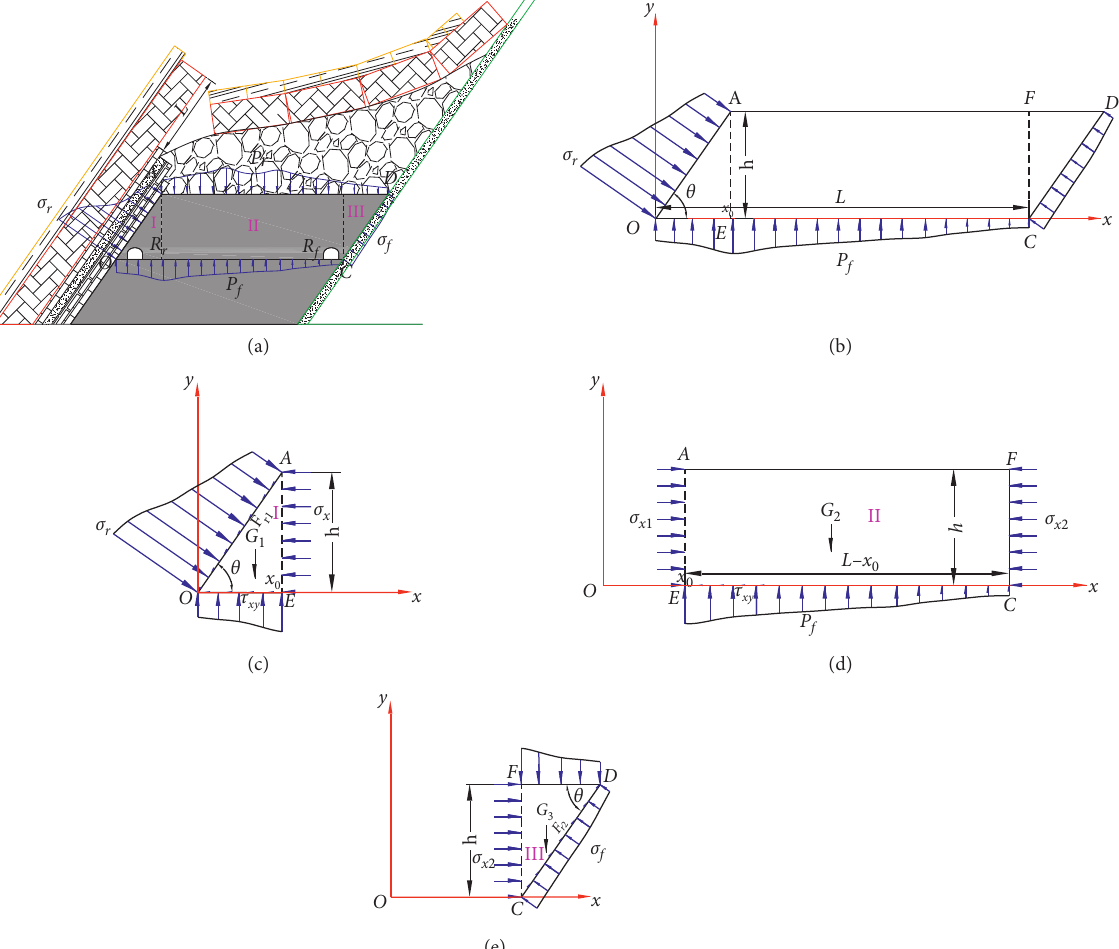
Figure 1: Mechanical model for horizontal slices mining of the SICS. (a) Mechanical model for horizontal slices mining of the SICS. (b) Mechanical model for the distribution of abutment pressure on the roof and stress of coal-rock in the working face. (c) Stress in the roof triangular zone. (d) Stress in the rectangular coal zone. (e) Stress in the floor triangular